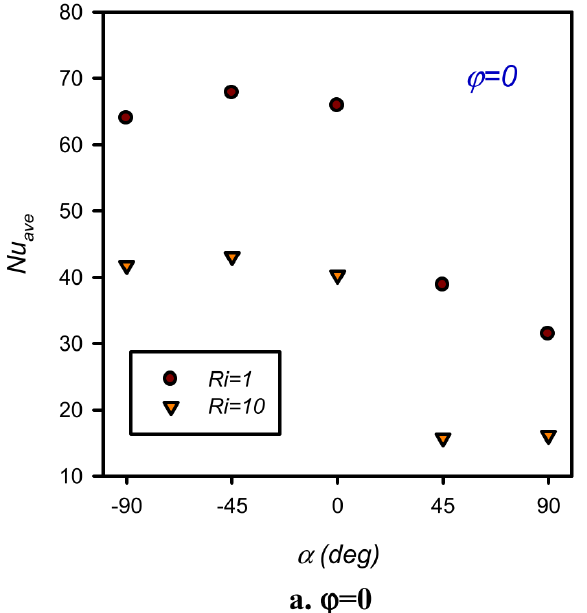
Figure 1. Changes of average Nusselt number with an attack angle of the heated wall for various volume fractions. Reprinted with permission from Ref. [16]. 2019, Elsevier.